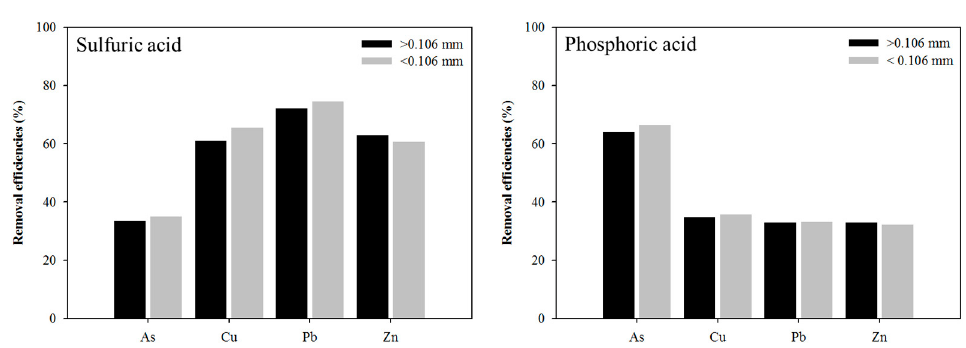
Figure 8. E ff ect of the size fraction ( ± 0.106 mm) on the extraction of As, Cu, Pb, and Zn from the batch Figure 8. Effect of the size fraction (±0.106 mm) on the extraction of As, Cu, Pb, and Zn from the batch test with 0.6 M sulfuric acid and 0.6 M phosphoric test with 0.6 M sulfuric acid and 0.6 M phosphoric acid.